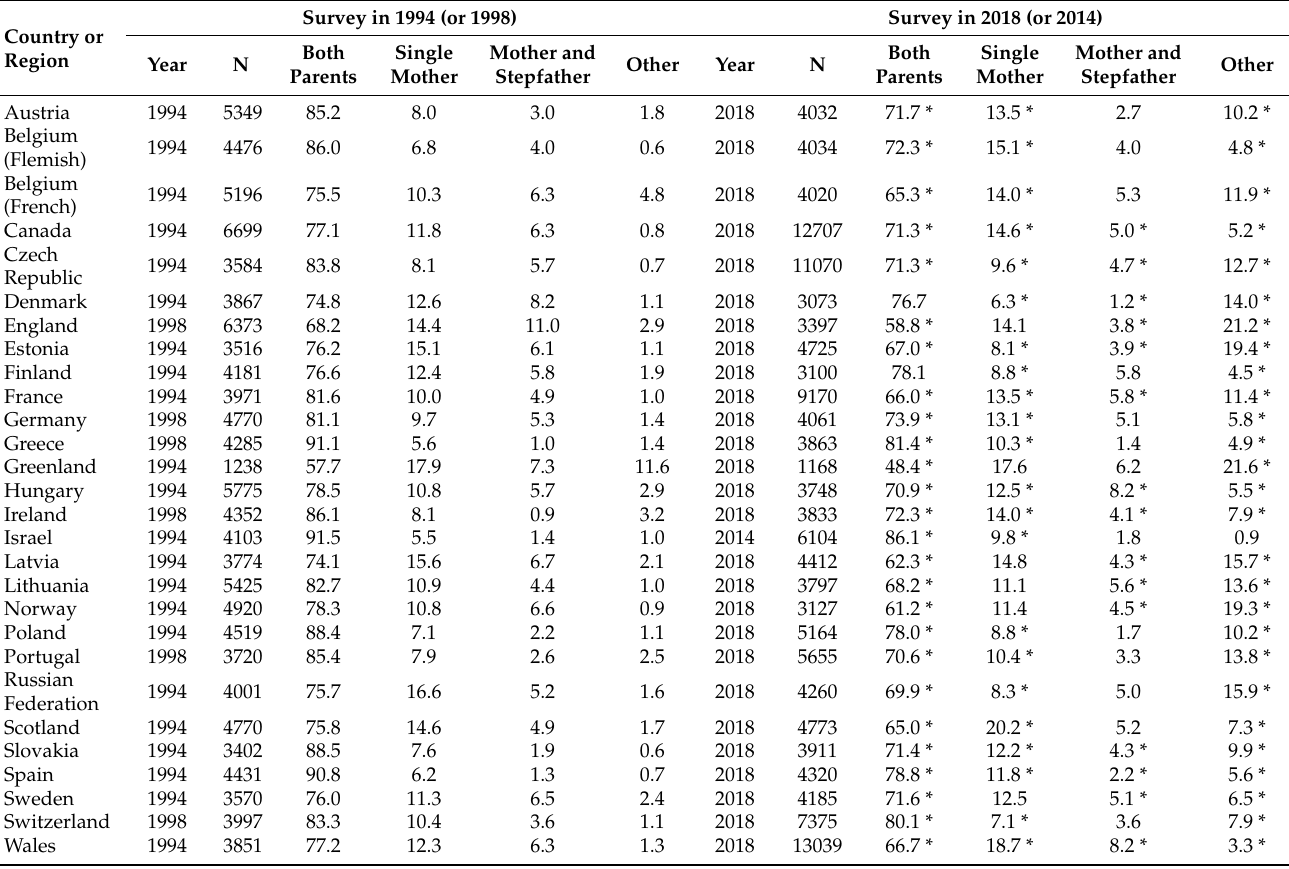
Table 2. Comparison of the family structure between surveys in 1994 (or 1998) and 2018 (or 2014) across 28 HBSC